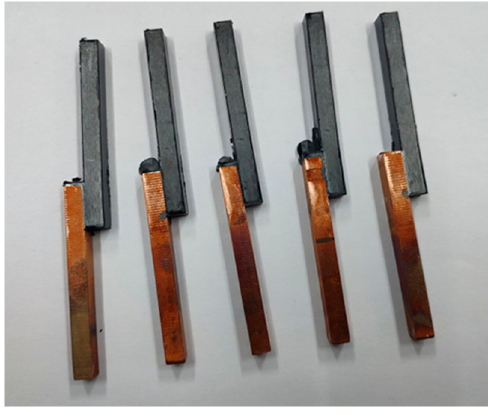
Figure 8. Schematic representation of the copper-PPS assemblies.